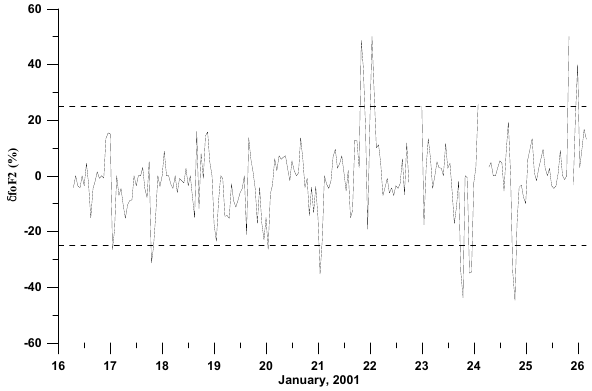
Fig. 6. Critical frequency deviation of the Ahemadabad station data from 16 to 26 January 2001.